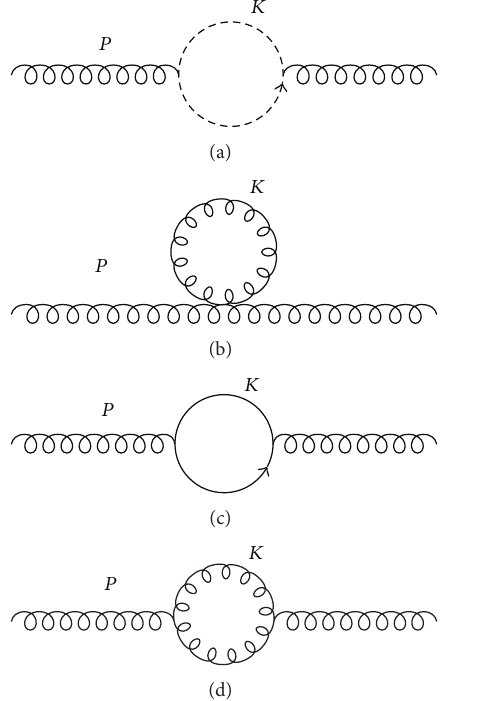
Figure 20: Feynman diagrams contributing to gluon self-energy up to one loop. (a) Ghost-gluon loop. (b) Four-gluon vertex. (c) Quark- antiquark pair creation. (d) Three-gluon